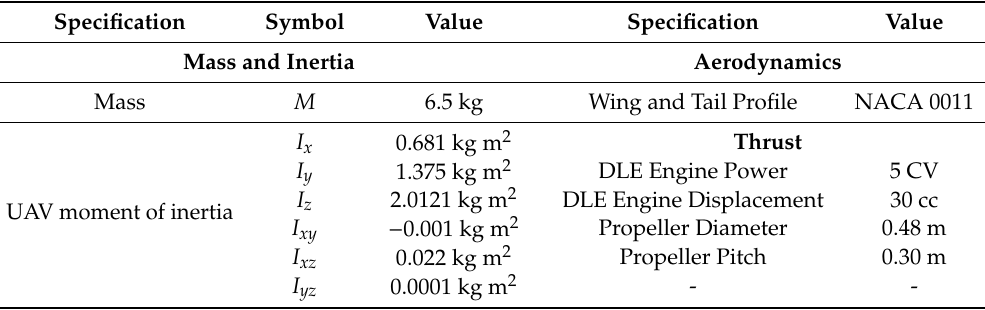
Figure 3. UAV geometric drawing, dimensions in millimeters. Table 1. Unmanned aerial vehicle (UAV) main features.